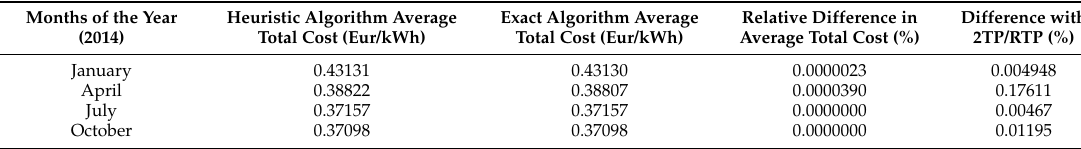
Table 3. Simulation Result of TOUP Model across representative seasons of the year.